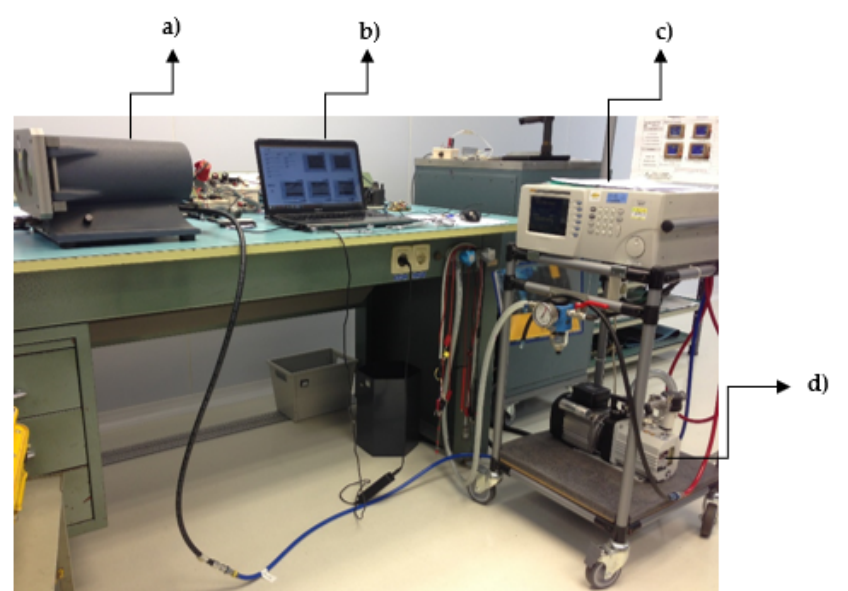
Figure 4. Calibration’ setup: ( a ) barometric chamber; ( b ) laptop computer; ( c ) Air Data Test Set (ADTS) and ( d ) vacuum pump. Table 4. Absolute pressure sensor calibration sheet.